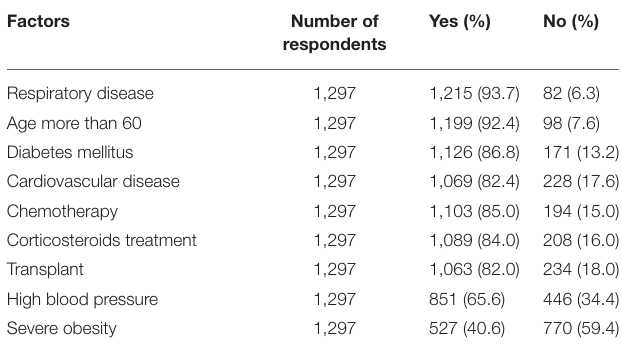
TABLE 3 | Knowledge of participants regarding factors making patients susceptible to